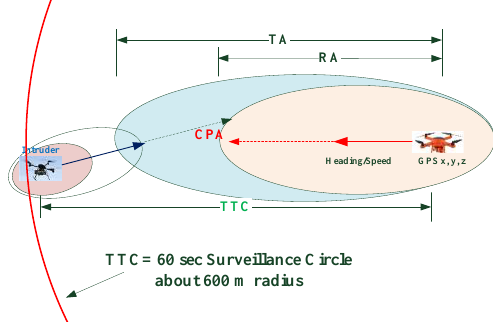
Figure 8. Concept of UTM detect and avoid (DAA) mechanism.